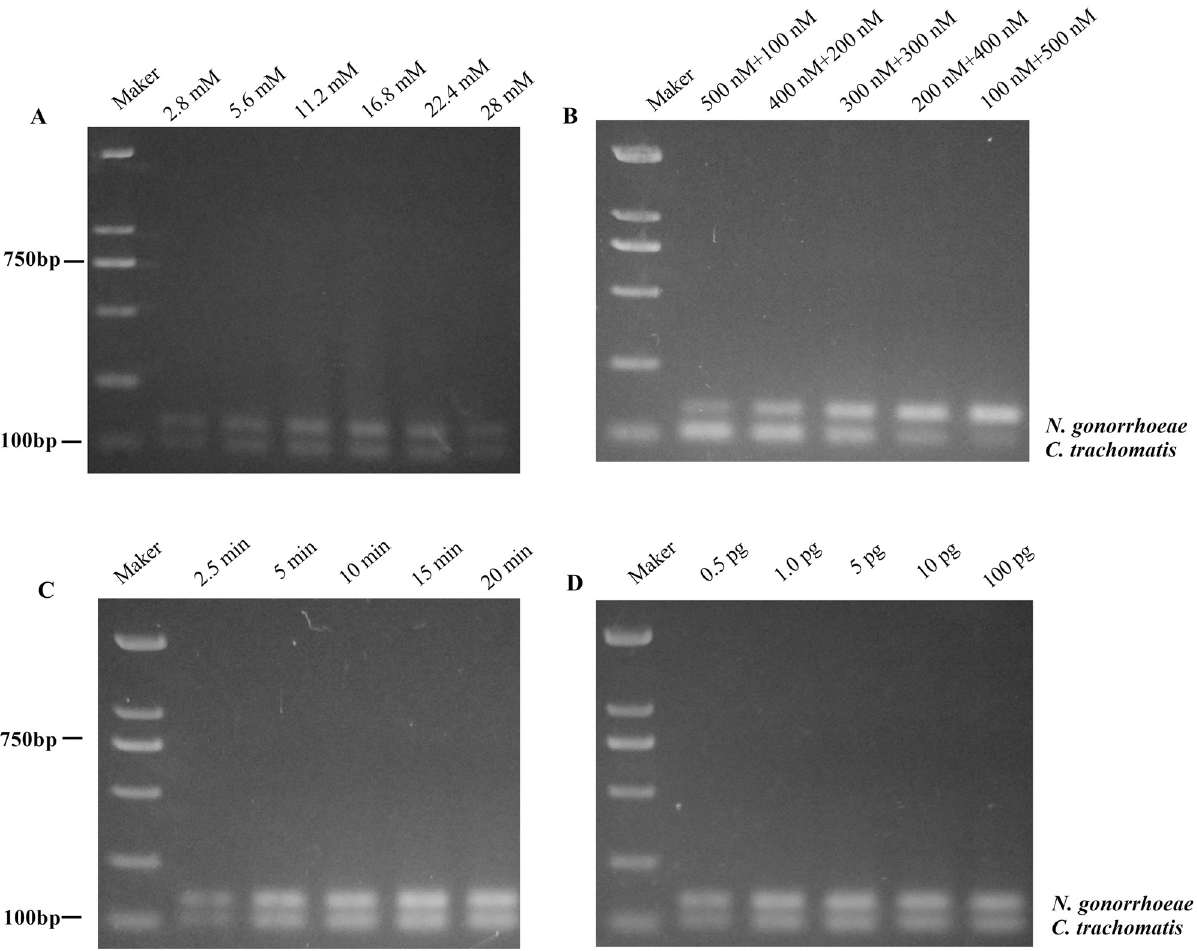
Fig 2. Optimization of multiple RPA reaction system. A: Comparison of amplification efficiency of multiplex RPA at different magnesium ion concentrations (38˚C, 20 min, CT 200 nM + NG 200 nM); B: Comparison of amplification efficiency of multiplex RPA at different combinations of primer pair concentrations (38˚C, 20 min, 16.8 nM Mg 2+ ); C: Comparison of amplification yields of multiplex RPA at different amplification times (38˚C, 16.8 nM Mg 2+ , CT 300 nM + NG 300 nM); D: Comparison of amplification efficiency of multiplex RPA at different template